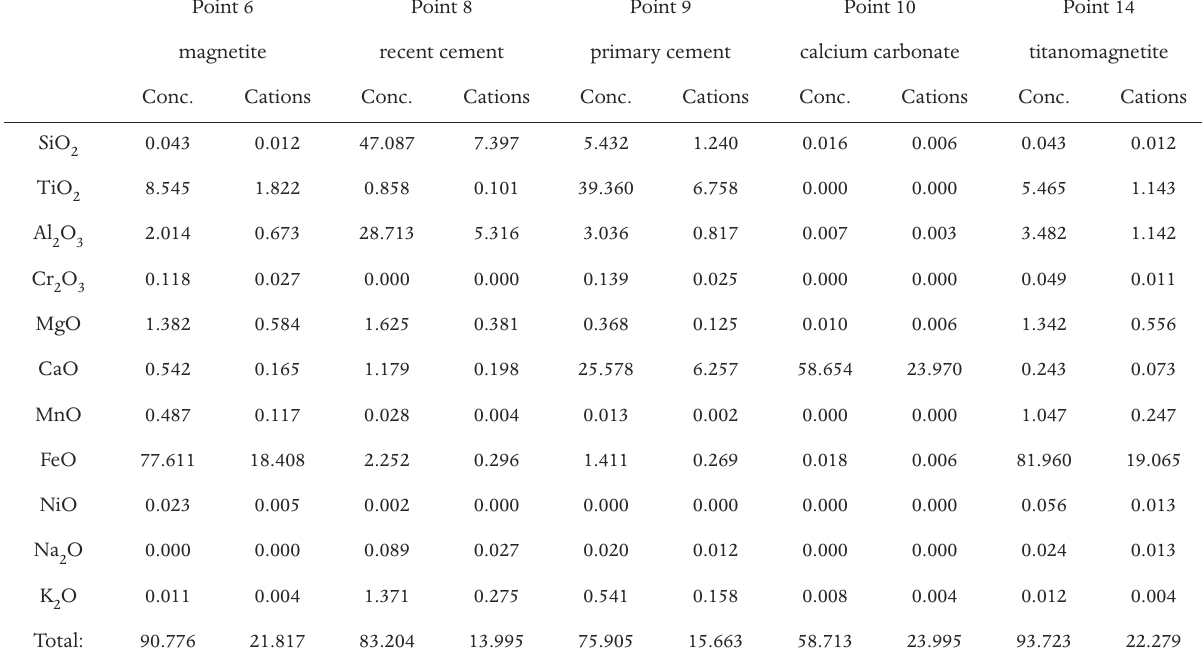
Table 1. Element concentrations obtained by EDS microprobe analysis of thin sections. Locations of points 6, 10, and 14 on thin sections are shown in Figure 3.